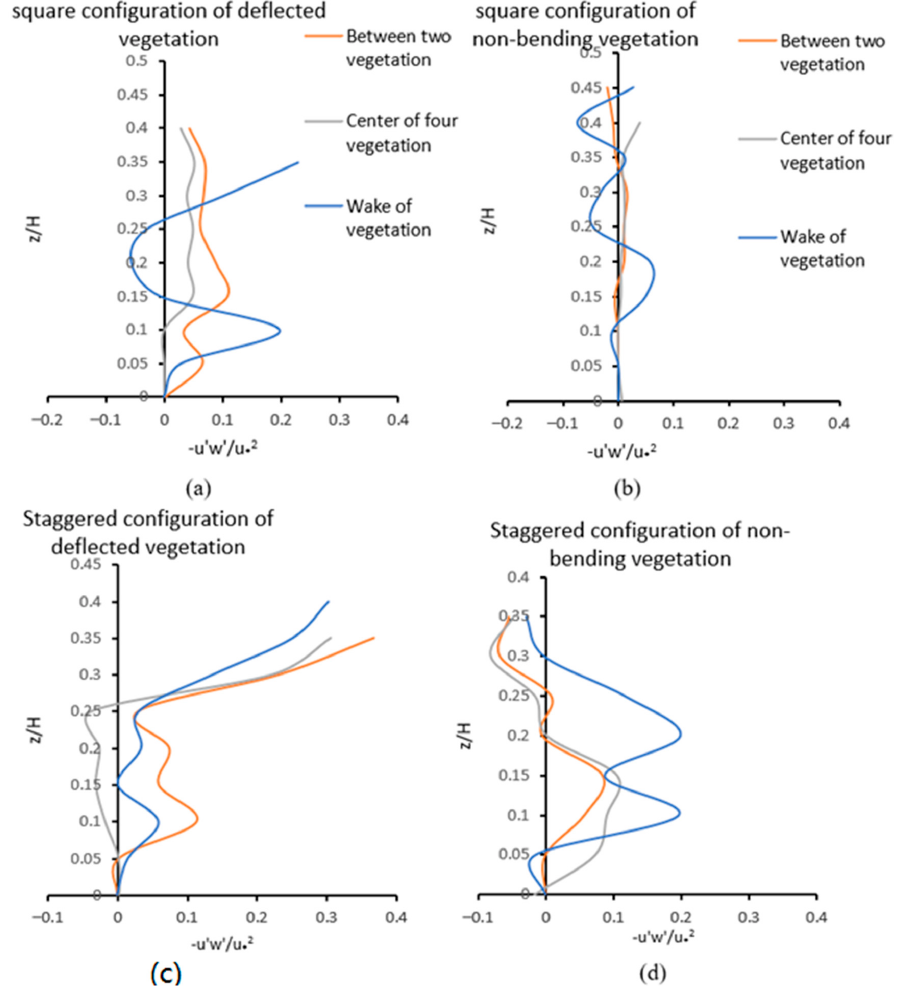
Figure 14. Normalized Reynolds Shear Stress (flow depth = 20 cm): ( a ) Square configuration of deflected vegetation in the wake zone of vegetation, between two vegetation elements and in the center of four vegetation elements with λ = 0.09; ( b ) Square configuration of non-bending vegetation in the wake zone of vegetation, between two vegetation elements and in the center of four vegetation elements with λ = 0.12; ( c ) Staggered configuration of deflected vegetation in wake of three random vegetation elements with λ = 0.17; ( d ) Staggered configuration of non-bending vegetation in wake of three random vegetation elements with λ =